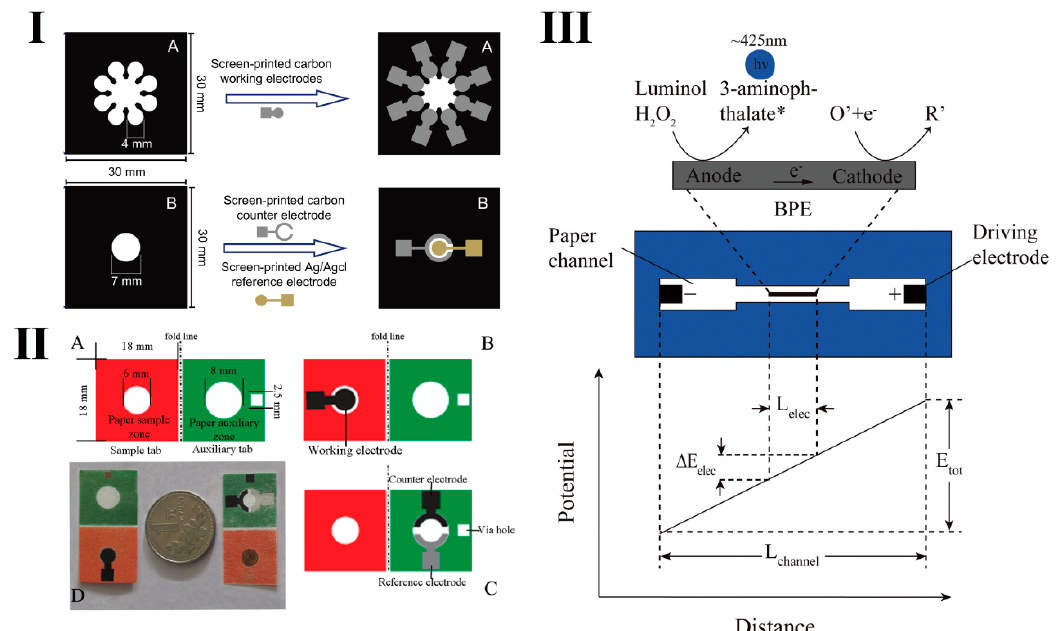
Figure 5. ( I ) Schematic of the process of making a 3D paper-based ECL device. Reproduced with permission from [109], published by Elsevier Ltd., 2012. ( II ) Schematic of folding paper-based three electrodes system. Reproduced with permission from [110], published by Elsevier B.V, 2014. ( III ) Schematic of ECL reaction of paper-based bipolar electrode. Reproduced with permission from [111], published by Elsevier B.V, 2016.